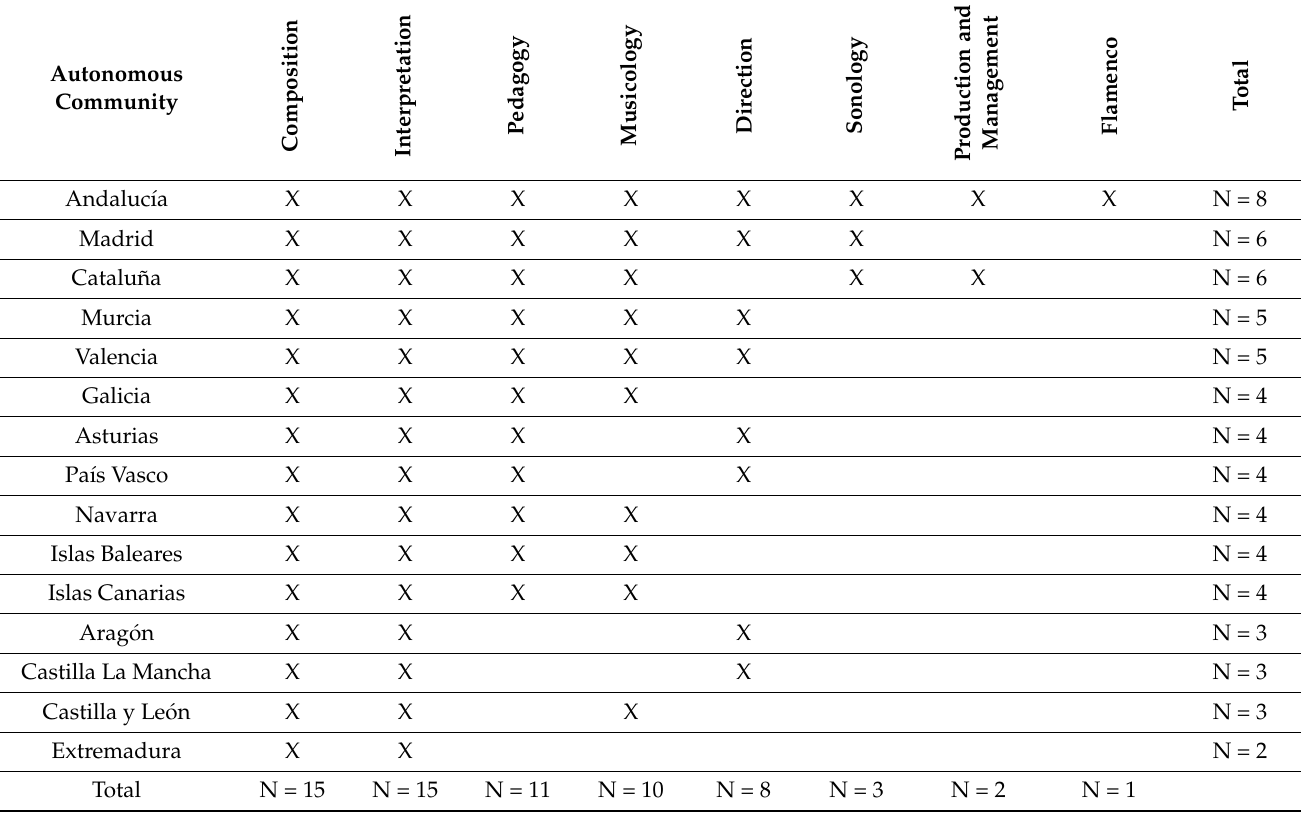
Table 1. Specialties that can be studied in the different Autonomous